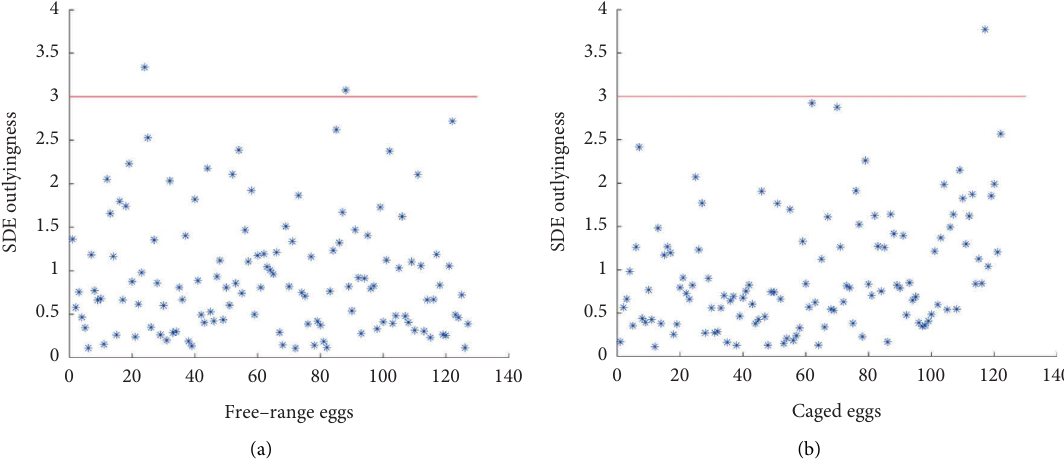
Figure 2: SDE outlier diagnosis of 127 free-range eggshells (a) and 122 caged eggshells (b) based on rescaled element data. Table 4: Classifcation of free-range and caged eggs using rescaled elemental data of eggshells by PLS-DA and LS-SVM. Models